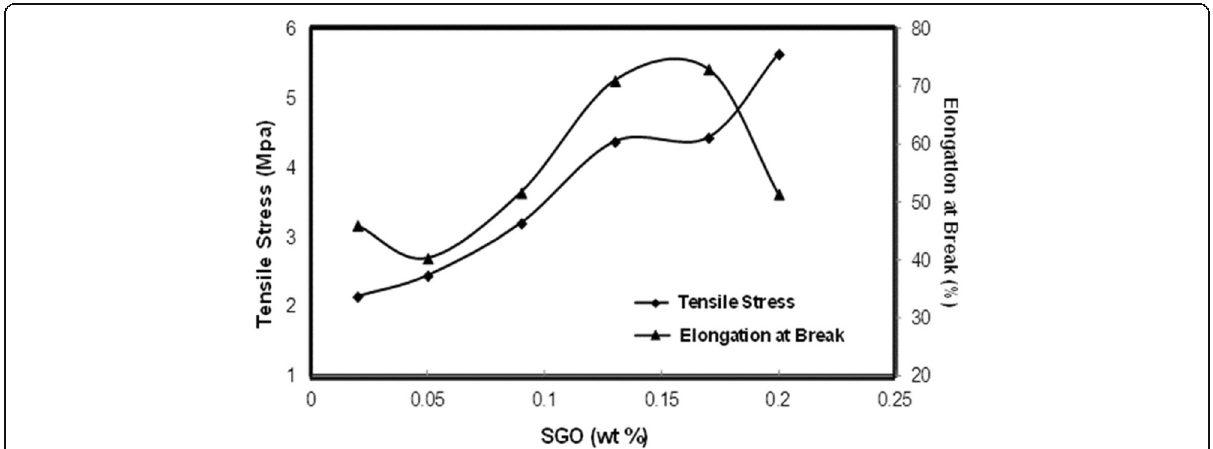
Fig. 8 Tensile stress and elongation at break of biomembrane with various SGO wt%